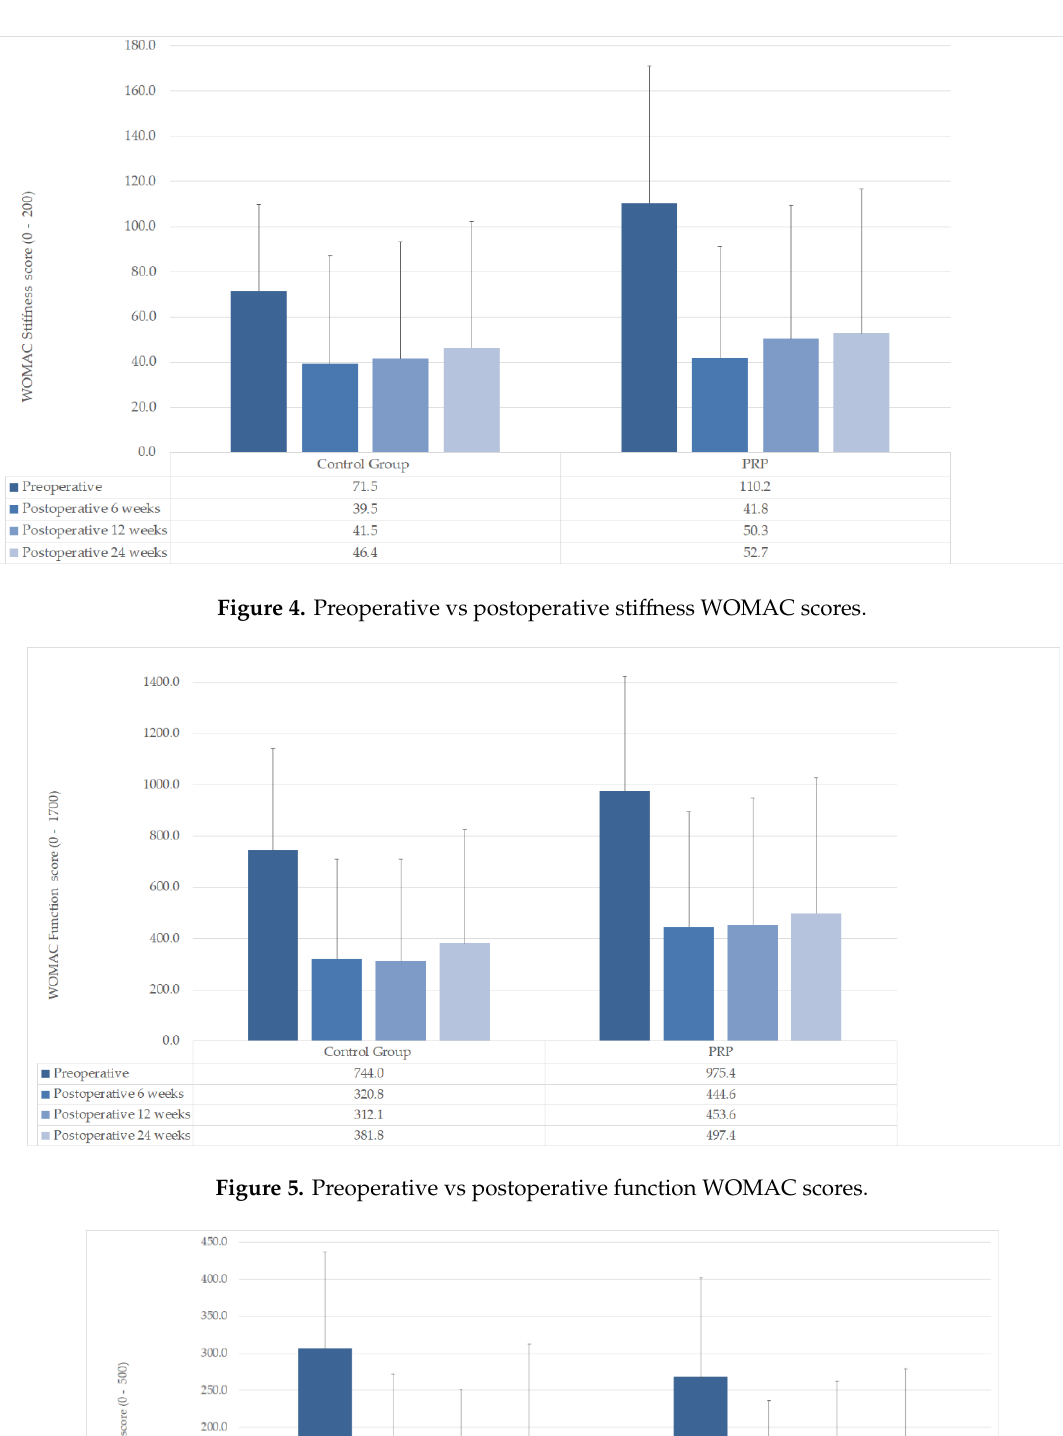
Figure 3. Preoperative vs postoperative total WOMAC score.